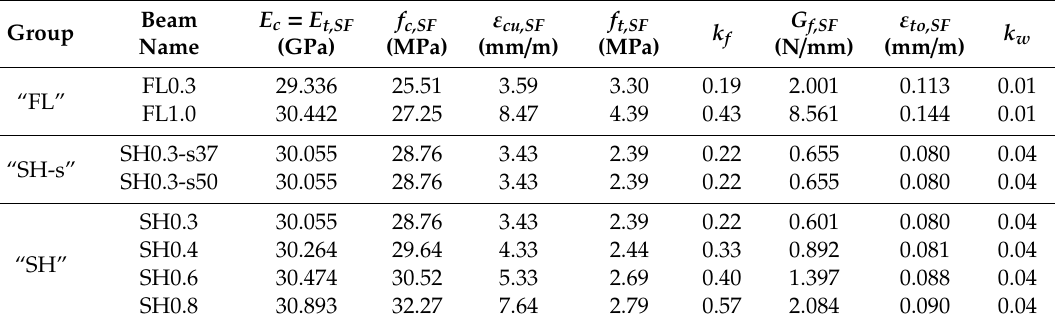
Table 2. Compressive and tensile properties of the steel fiber-reinforced concrete (SFRC) of each tested